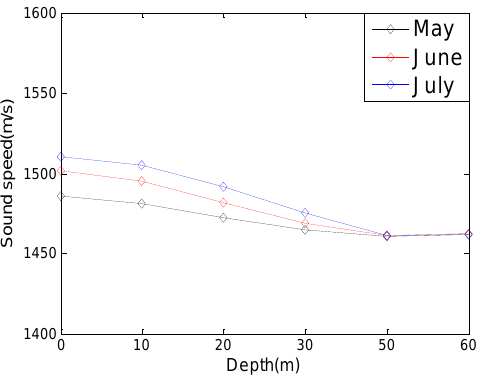
Figure 7. Average sound speed with different water depths.